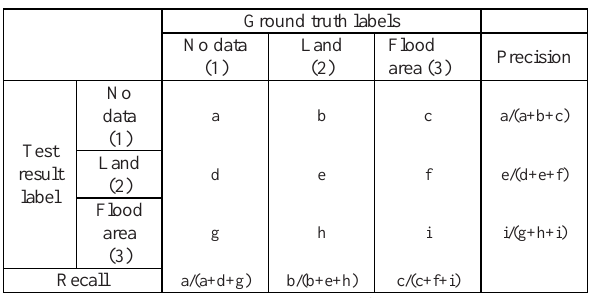
Table 5. Accuracy assessment for test data set